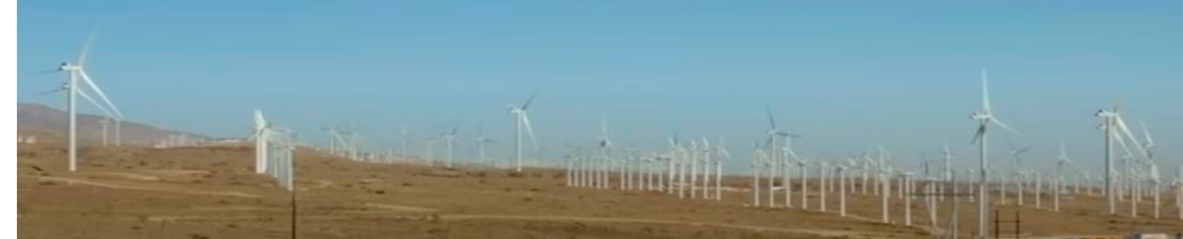
Figure 18. Horizontal axial wind turbine (VAWT) large-scale land installations [36,39].